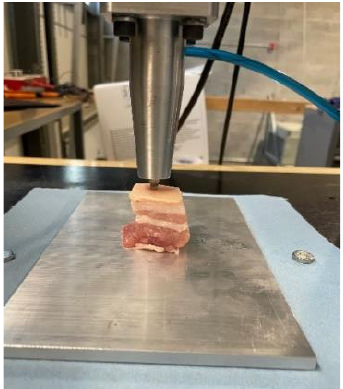
Figure 17. Close-up of porcine tissue and jet injector nozzle.